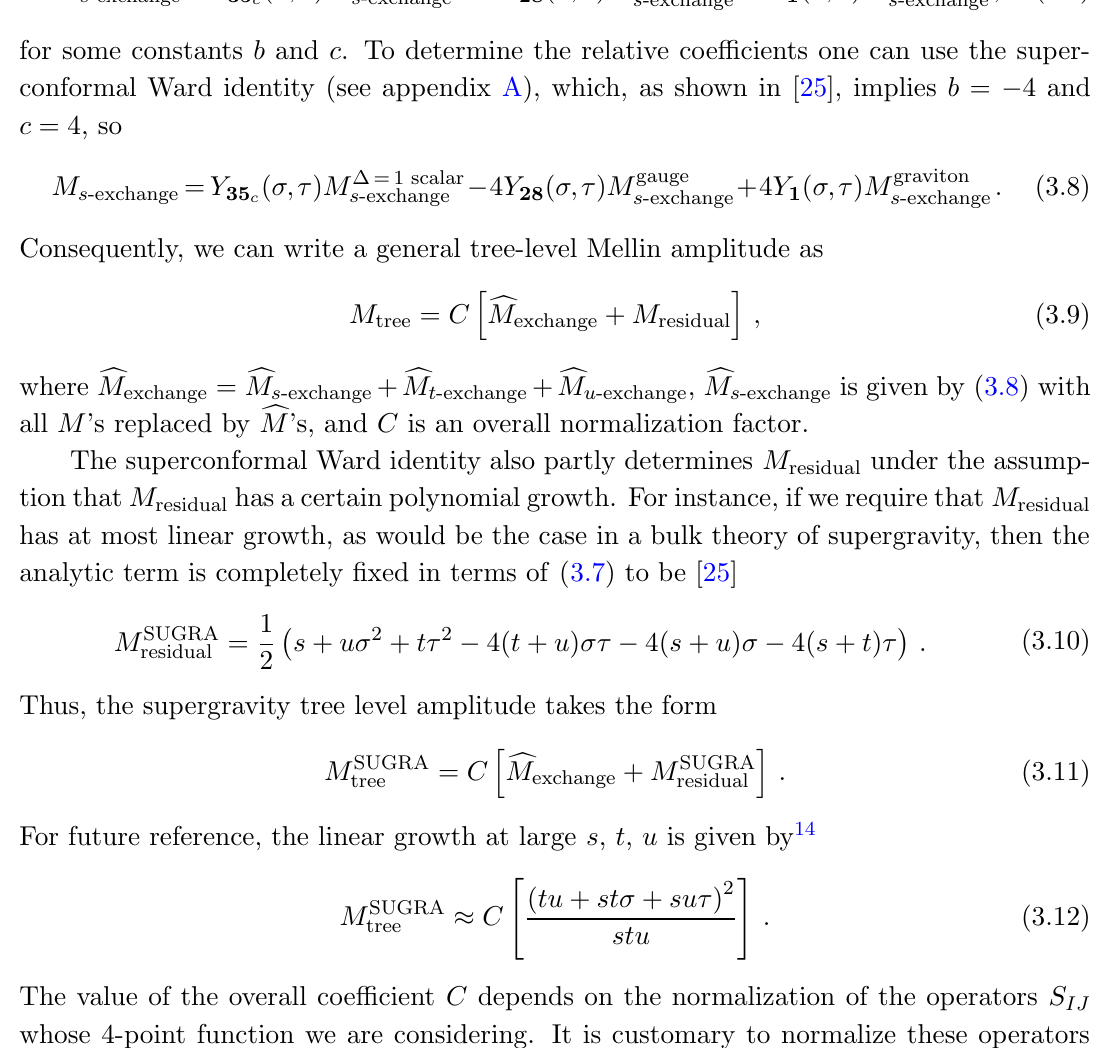
table 1, the S (cid:2) S OPE contains two half-BPS operators: the stress tensor multiplet whose bottom component is S itself, and the ( B; +) multiplet whose component operators all